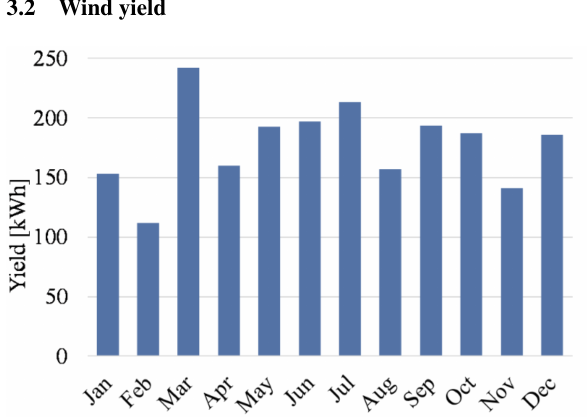
Figure 10. Wind yield for 10*500W LWS turbines.